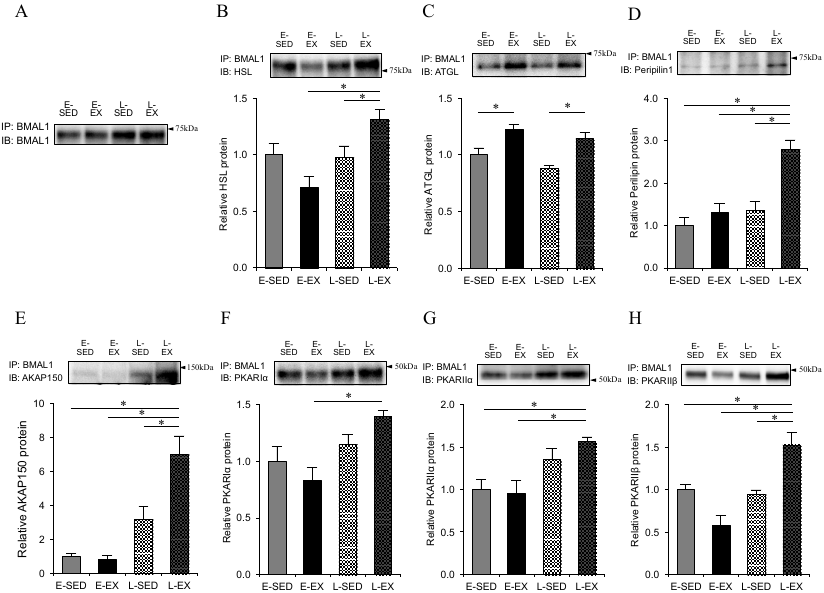
Figure 6. Association of BMAL1 with several lipolytic machineries in primary adipocytes isolated from epididymal adipose tissues. ( A ) Direct interaction between BMAL1 and BMAL1 revealed by the co-immunoprecipitation assay. Both lysates and immunoprecipitates (IP) were subjected to immunoblotting with ( B ) anti-HSL, ( C ) anti-ATGL, ( D ) anti-Perilipin1, ( E ) anti-AKAP150, ( F ) anti-PKA-RI α , ( G ) anti-PKA-RII α , and ( H ) anti-PKA-RII β antibodies. Relative protein expression levels of each band in E-EX and L-EX groups (levels in respective sedentary controls are set to 1). In all experiments, data are presented as the means ± S.E. ( n = 6). * p < 0.05. The abbreviations for the groups of rats are shown in Figures 2 and 3.